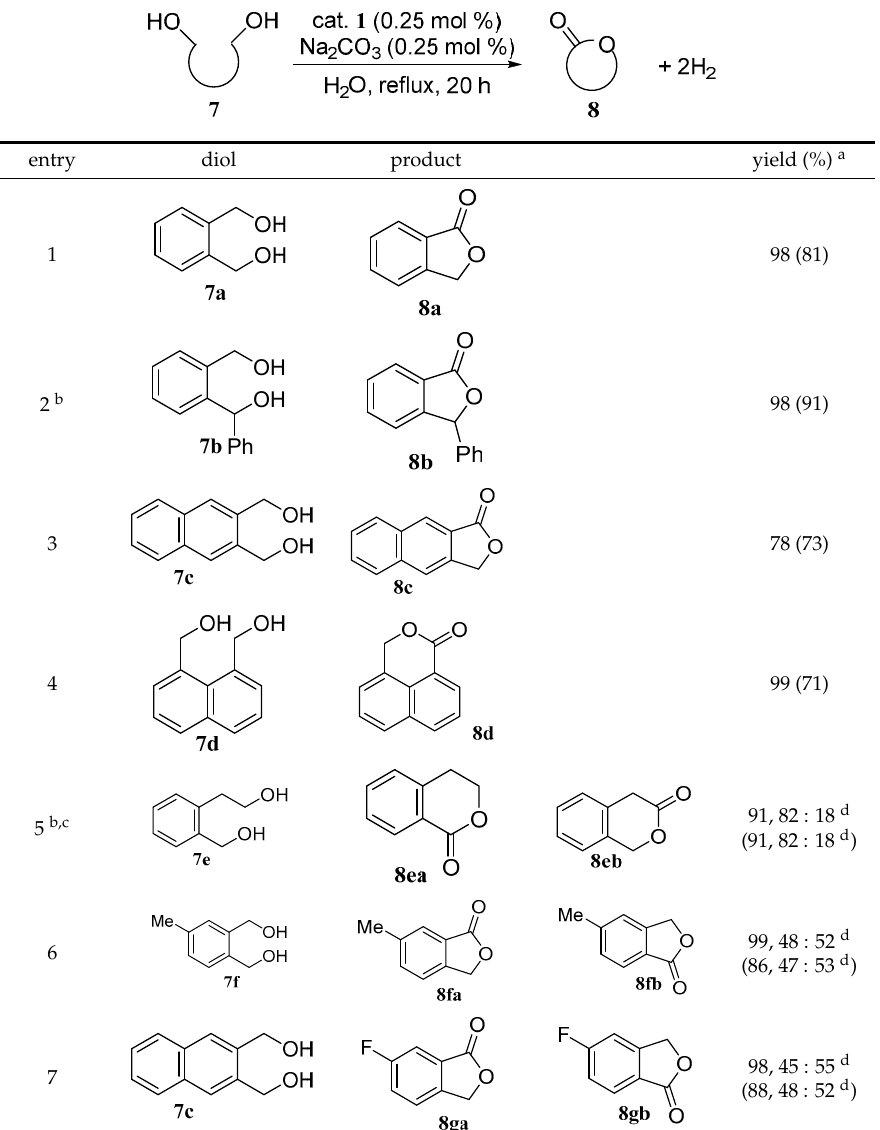
Table 4. Dehydrogenative lactonization of diols in aqueous media catalyzed by 1